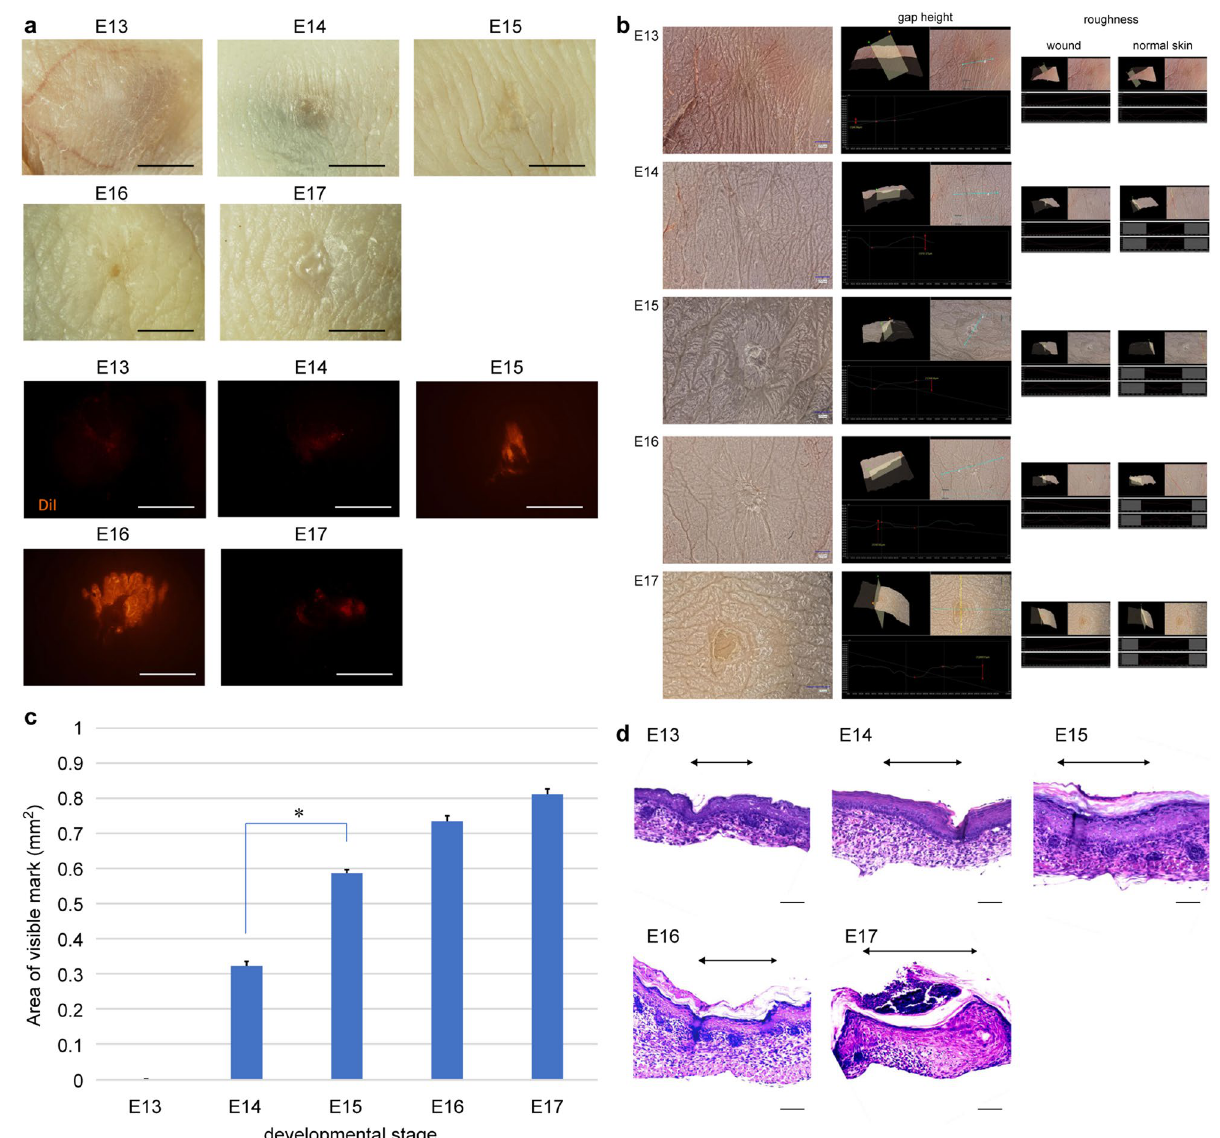
Figure 2. Wound healing in mouse fetuses. ( a ) Gross photograph at 72 h after wounding showing complete skin regeneration without scarring in E13 wounds. Visible marks were observed in wounds made at E14 or later. All wounds showed subcutaneous DiI uptake, which labeled the wound site. Scale bar = 1 mm. ( b ) Representative image obtained 72 h after wounding. The skin texture was regenerated, and the wound was almost free of depression compared to the surrounding normal skin in E13 wounds, but a visible mark and depressions in the surrounding skin were observed in E14 wounds. In addition, inside the visible mark in E14 wounds, the roughness was reduced compared to that of normal skin. ( c ) Comparison of the wound 72 h after wounding. n = 5 for each developmental stage. ( d ) H&E staining of the wound after 72 h showing healing of the dermis and other structures up to E16, but the dermis was replaced by thick scar tissue at E17. Scale bar = 100 µm. ( e ) Timing of the transition between epidermal and dermal regeneration during mouse development. ( g ) Regeneration of the epidermis and dermis over time, focusing on the wound margin. H&E images. In E13 wounds, the dermis moved into the skin defect earlier than the epidermis. In wounds made at E14 or later, the epidermis moved into the wound earlier than the dermis, and the leading edge contacted the fascia. In E16 wounds, the dermis regenerated, but in E17 wounds, cells derived from the fascia accumulated in the wound, forming scar tissue. Scale bar = 100 µm. ( g ) SEM images of wound healing at E13, E14, and E15. Scale bar = 200